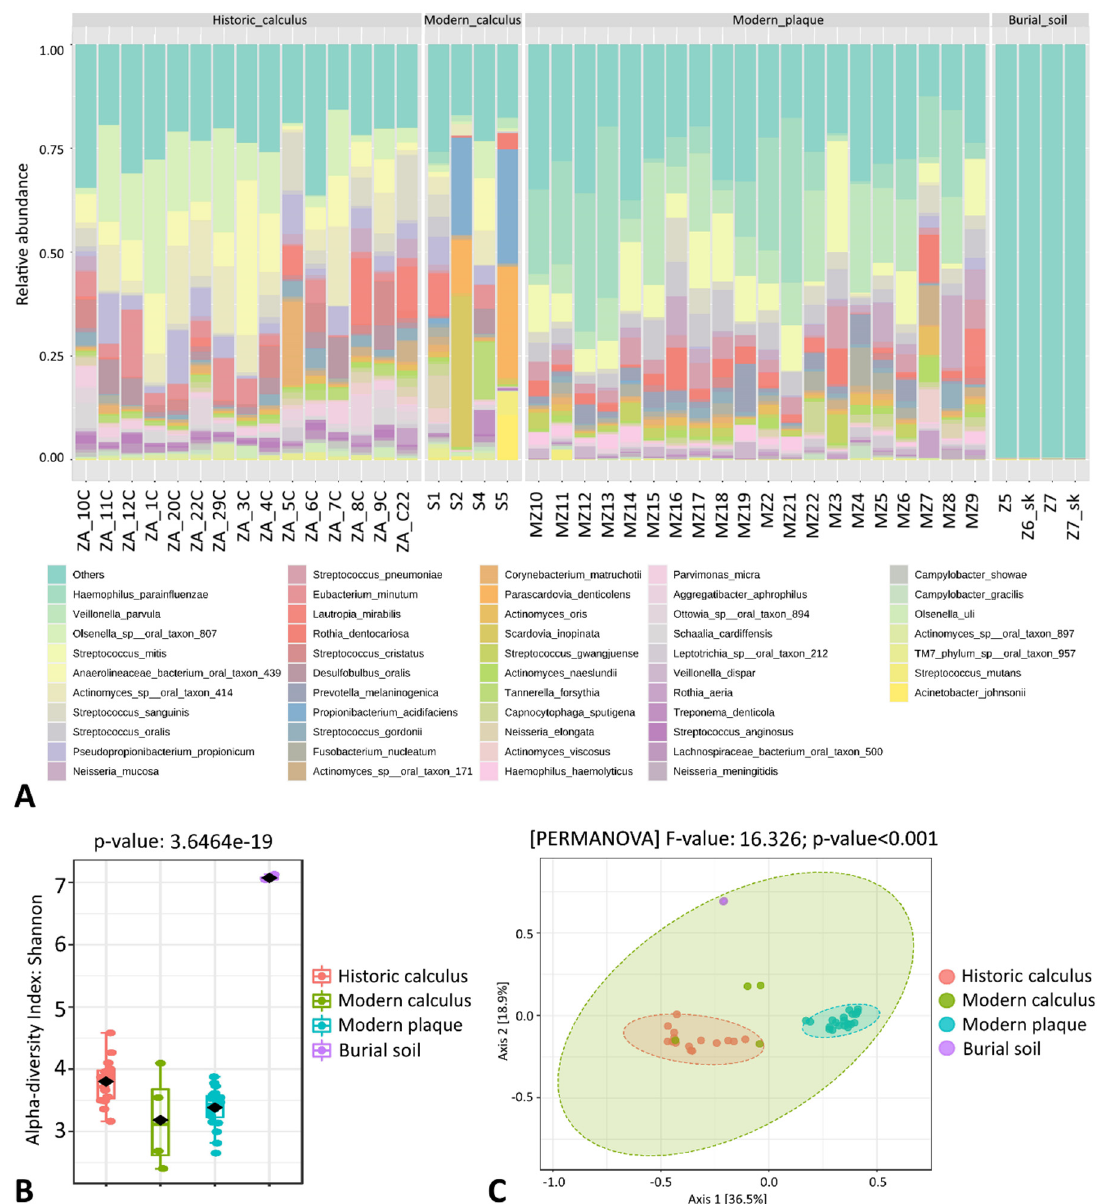
Figure 1. Species-level comparison of bacterial profiles in 16–17th century human archaeological dental calculus, modern dental calculus, modern dental plaque and burial soil samples: ( A ) Stacked plots of the taxonomic classification. The abundances of the most abundant species are shown; ( B ) Shannon diversity analysis; ( C ) Principal coordinates analysis (PCoA) derived from Bray–Curtis distances among samples of the four groups ( p < 0.001 by PERMANOVA). For each axis, in square brackets, the percent of variation explained was reported.